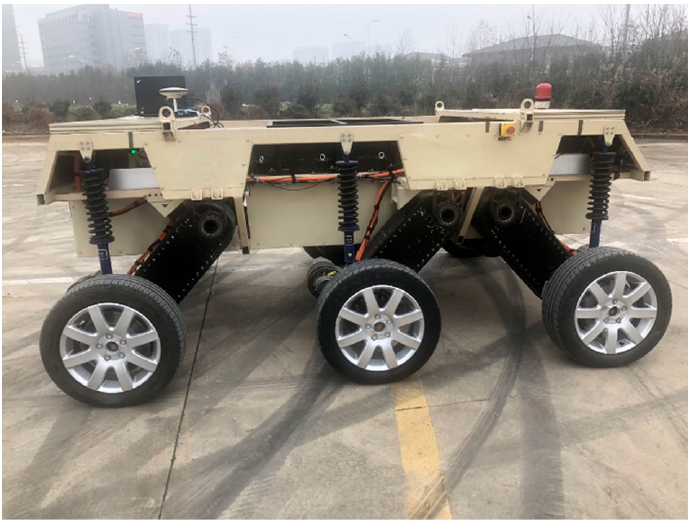
Figure 6. The experimental platform.